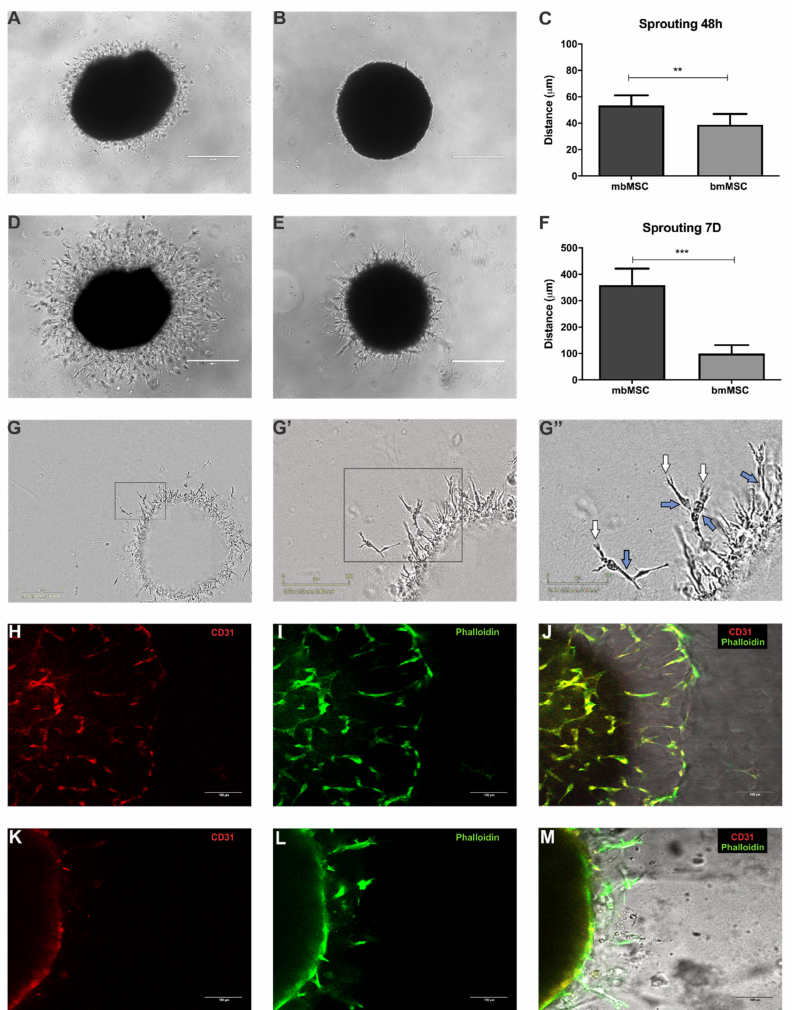
Figure 1. Sprouting from the 3D spheroids formed by mbMSC ( n = 7) and bmMSC ( n = 6). Representative images of ( A ) mbMSC and ( B ) bmMSC spheroids after 48 h in Matrigel TM GFR with EGM-2 medium. mbMSC spheroids showed more invasive cells compared to bone marrow spheroids. ( C ) Quantitative analyses of sprout length after 48 h. Distance reached by mbMSC spheroids was significantly longer than bmMSC spheroids (50.77 ± 8.80 µ m vs. 38.76 ± 8.19 µ m, ** p < 0.01). Representative images of ( D ) mbMSC and ( E ) bmMSC spheroids after 7 days in Matrigel TM GFR with EGM-2 medium. mbMSC spheroids showed extensive development while sprouting of bmMSC spheroids was significantly reduced. ( F ) Quantitative analysis of sprout length after 7 days. Distance quantification of mbMSC-derived spheroids was significantly longer than of bmMSC (358.51 ± 62.44 µ m vs. 99.99 ± 31.89 µ m *** p < 0.0001). ( G – G” ) Representative images of mbMSC invasive cells in di ff erent magnifications showing morphological characteristics similar to endothelial cells. ( G” ) Presence of filopodia-like extensions in their extremities, recapitulating morphologically to tip cells as indicated by white arrow and linear organization similar to stalk cells as indicated by blue arrow. ( H – M ) Immunofluorescence of mbMSC ( n = 6) and bmMSC ( n = 5) spheroid after 14 days in culture. ( H – K ) mbMSC and bmMSC expressed CD31 during angiogenic sprouting assay as shown in red. ( I , L ) Cell’s cytoskeleton is shown in green as indicated by phalloidin staining. ( J , M ) Merged images of immunofluorescence and phase contrast. All scale bars are indicated in the